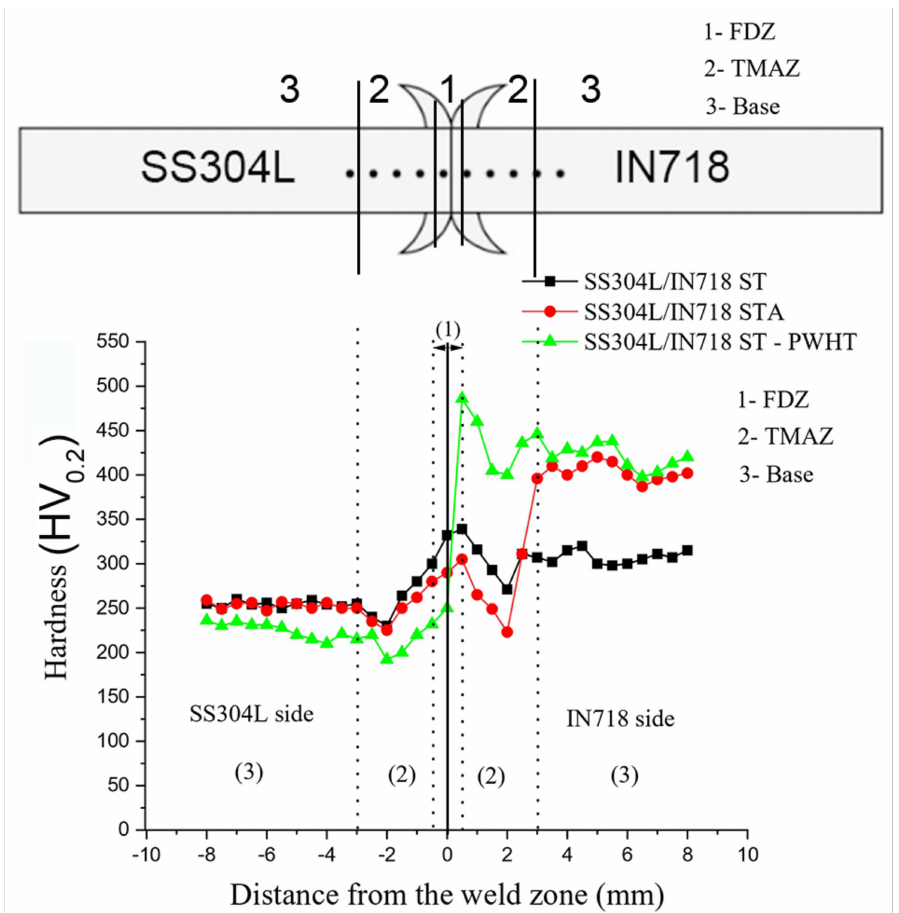
Figure 14. Hardness distribution across the weld interface of dissimilar SS304L/IN718 rotary friction welded joints in the as-welded ST, STA, and PWHT